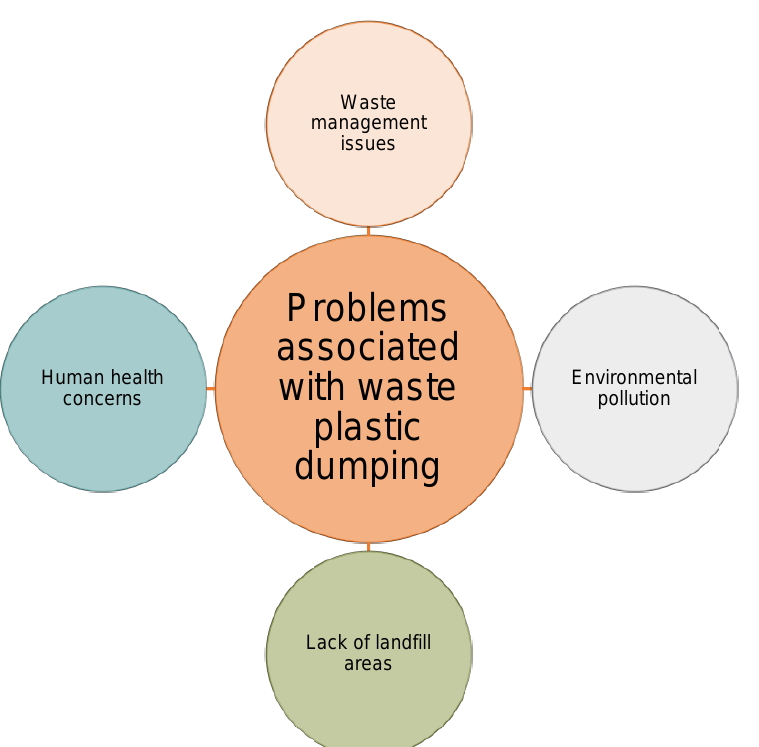
Figure 13. Disadvantages of plastic waste disposal in landfills.